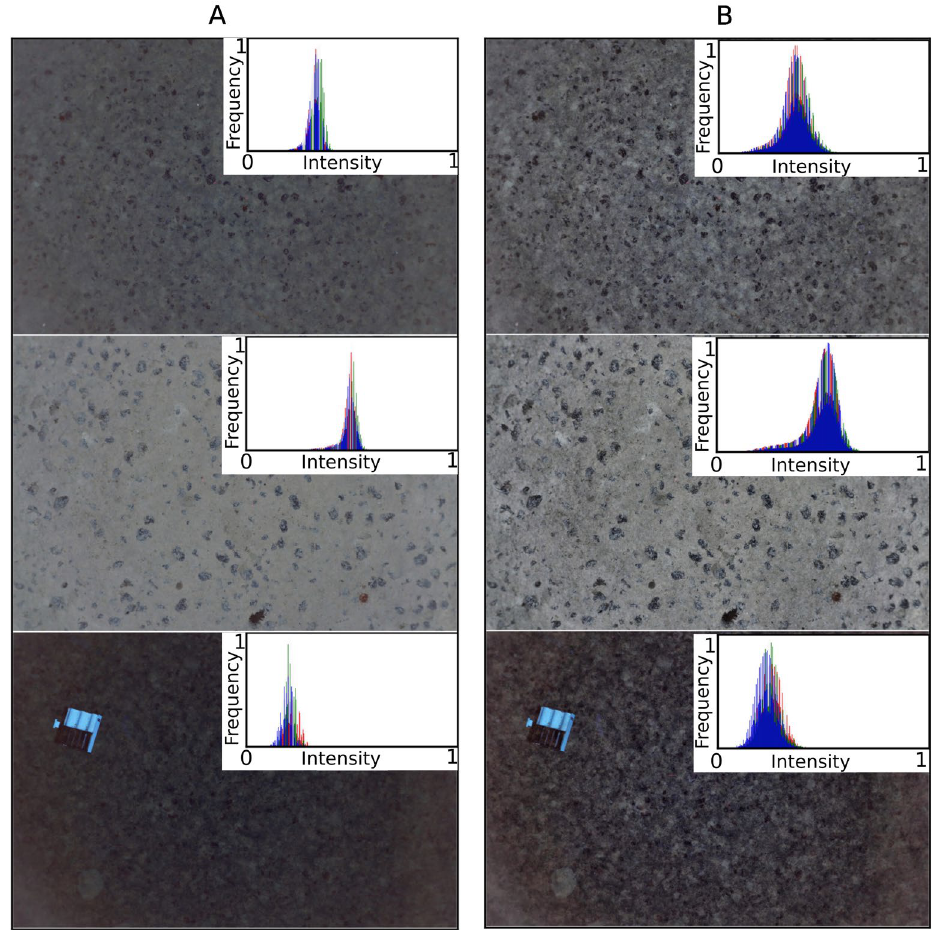
Figure 3. Comparison between sets of ( A ) images corrected for illumination drop-off and, ( B ) adaptive histogram equalized images. Also shown as insets are the intensity histograms showing the distribution of the pixel values for each RGB